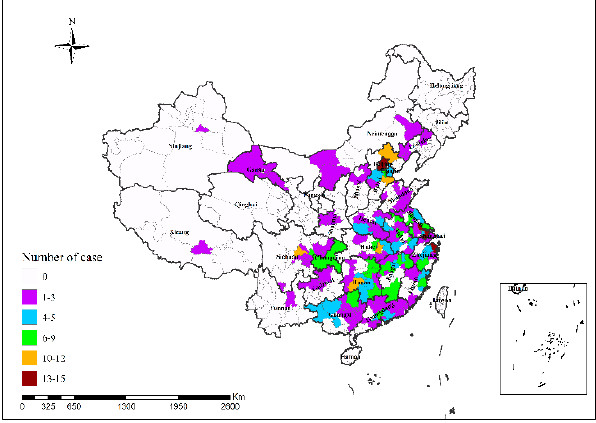
Figure 6. Spatial pattern of H7N9 outbreaks in China in 2017.